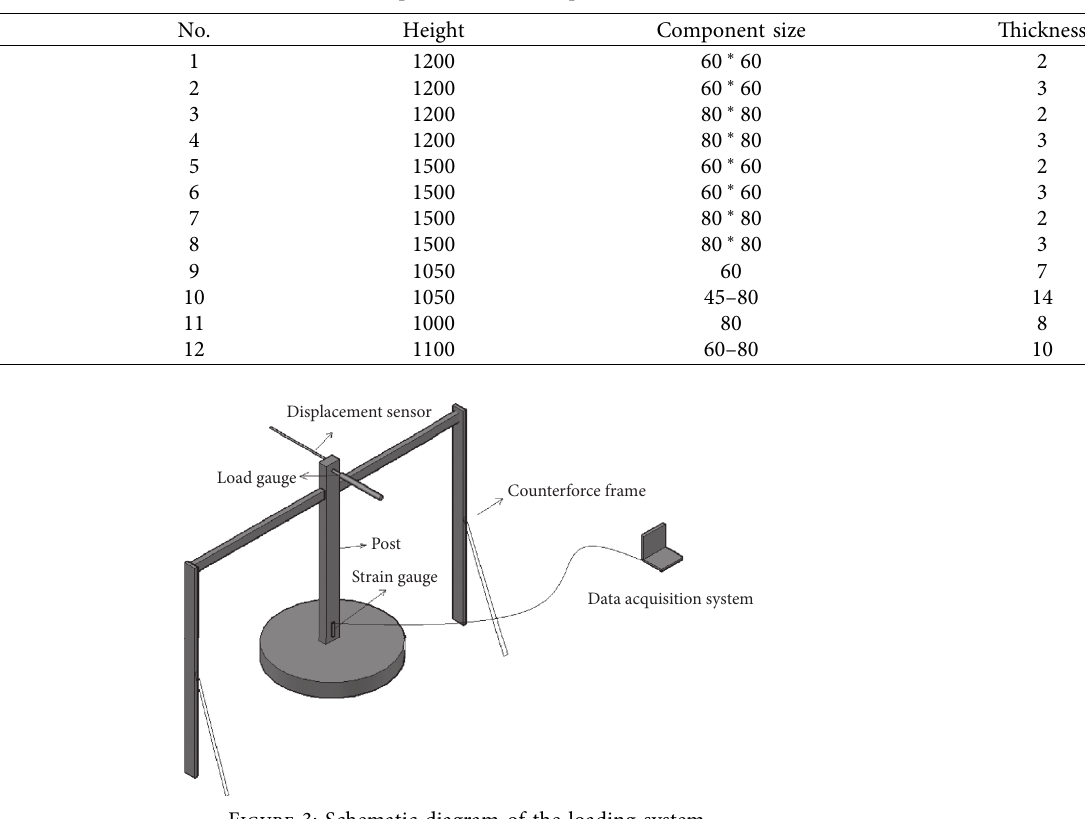
Figure 3: Schematic diagram of the loading system.